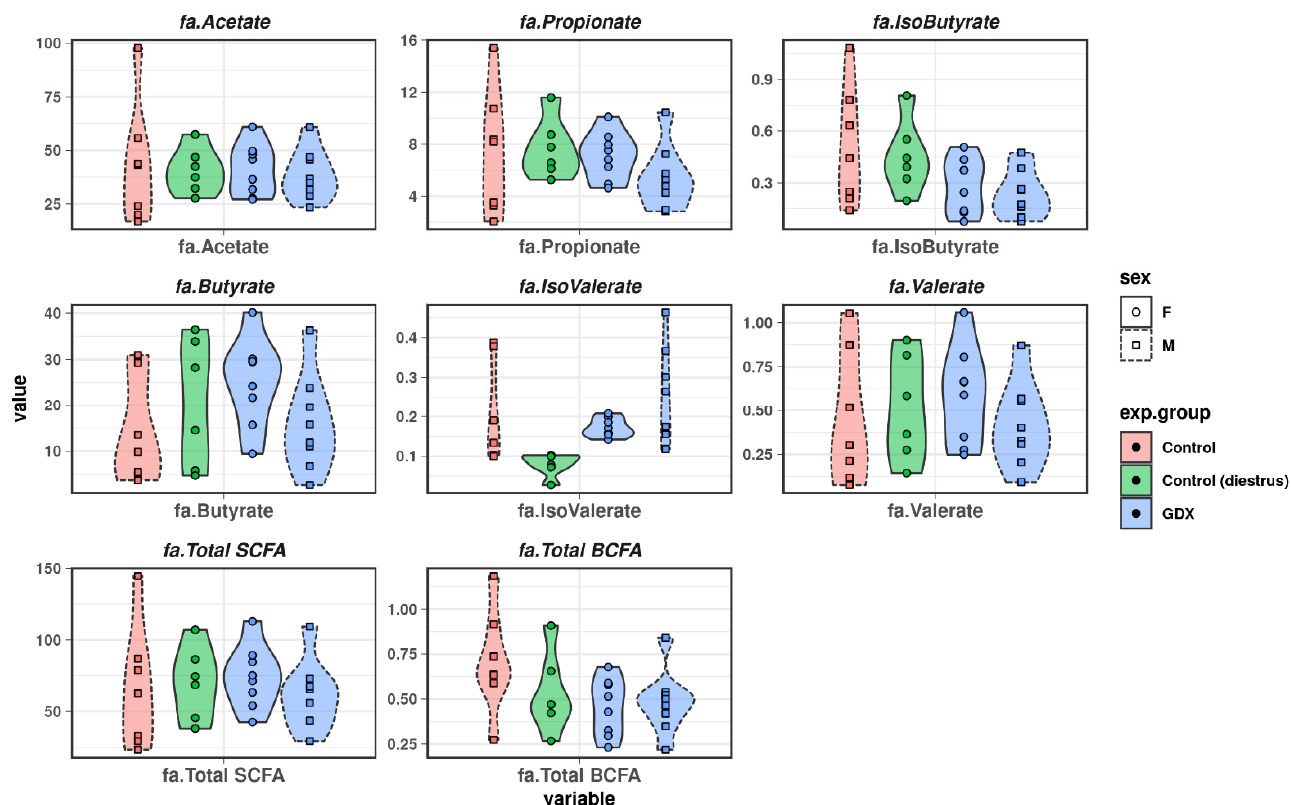
Figure 6. Faecal short-chain fatty acid and branched chain fatty acid levels in all